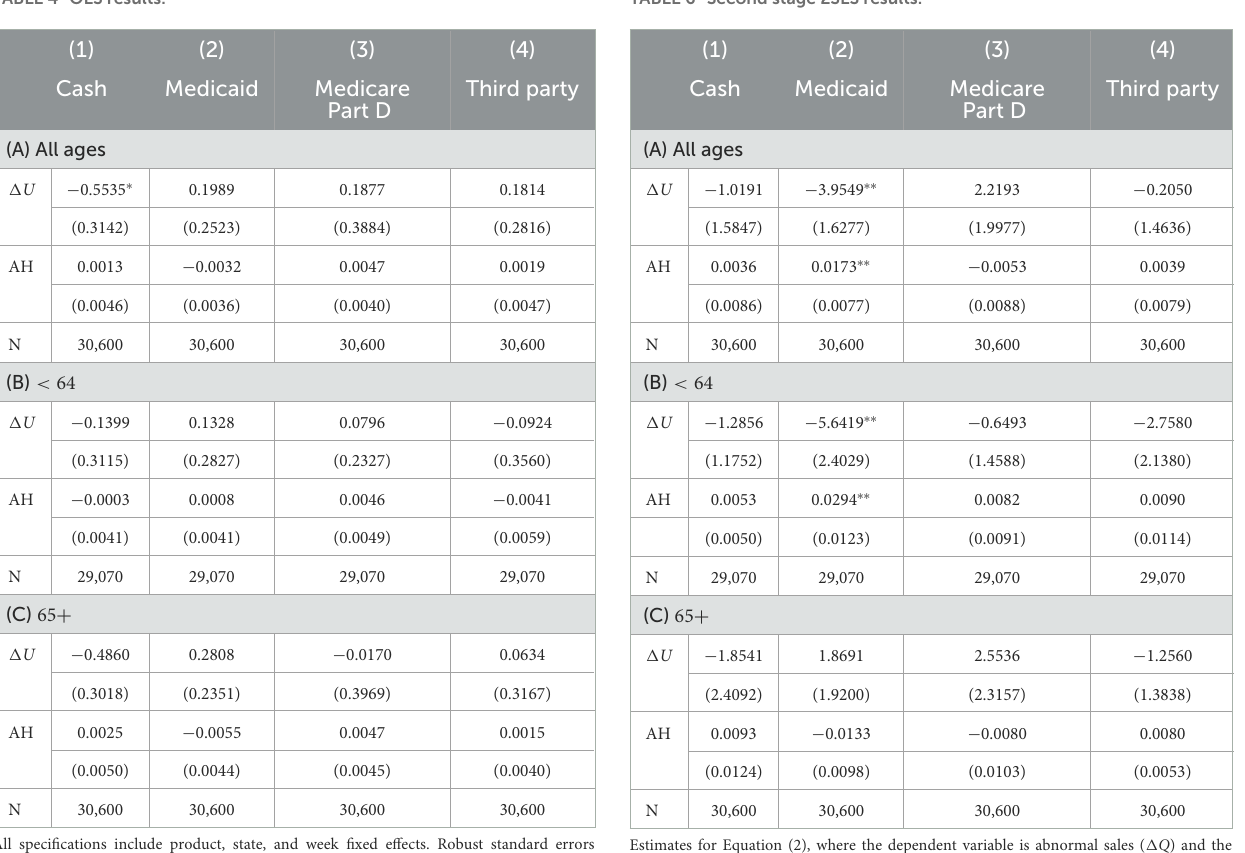
TABLE 6 Second stage 2SLS